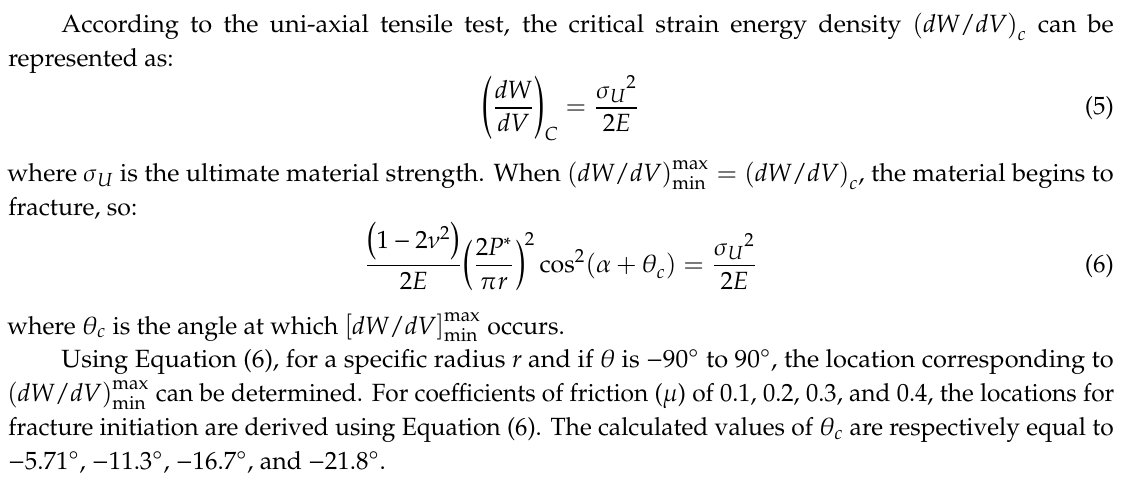
Figure 4. Illustration of fracture initiation.